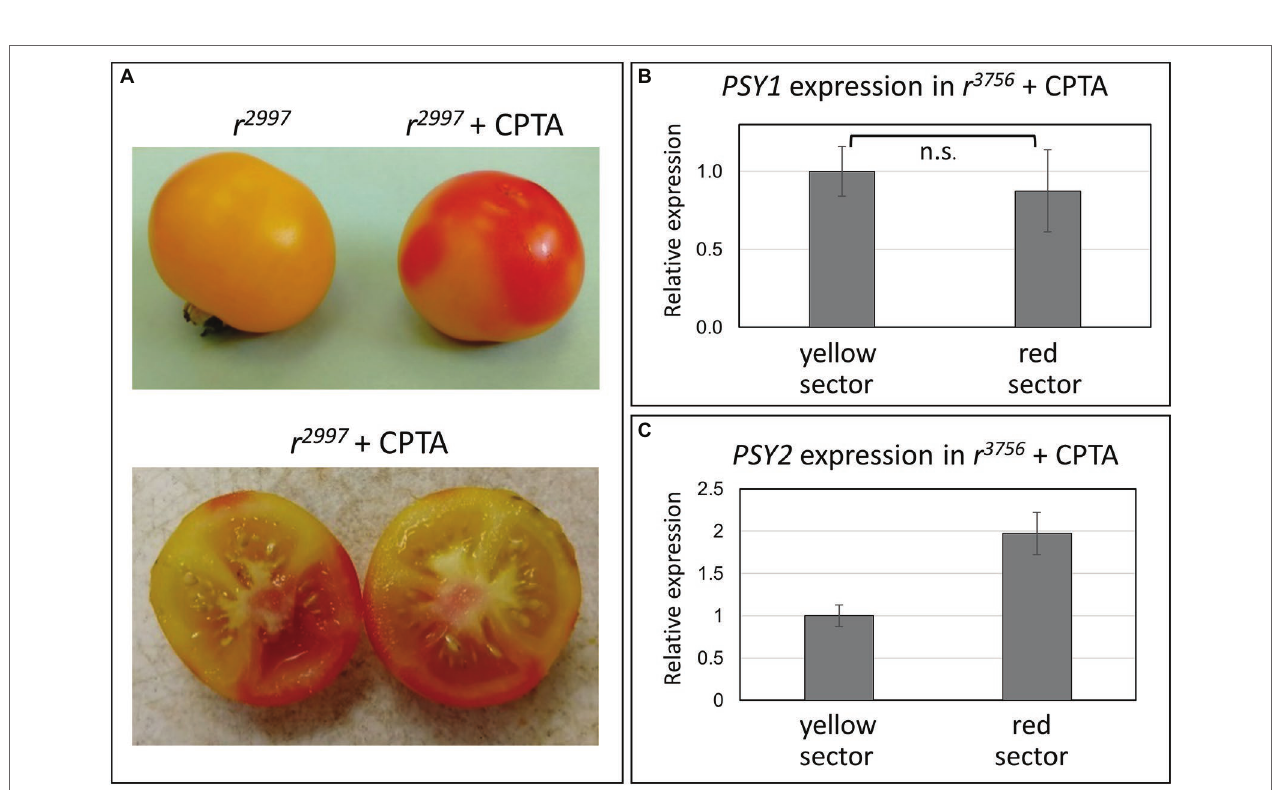
FIGURE 5 | Effects of CPTA on pigment accumulation in tomato fruit. (A) Fruits of the yellow flesh r 2997 mutant before and after CPTA treatment. (B) Expression of PSY1 in the yellow and red fruit sectors. (C) Expression of PSY2 in the yellow and red fruit sectors. Different tested parameters were compared using the “Compare all pairs” (Tukey–Kramer), p < 0.05. n.s. no